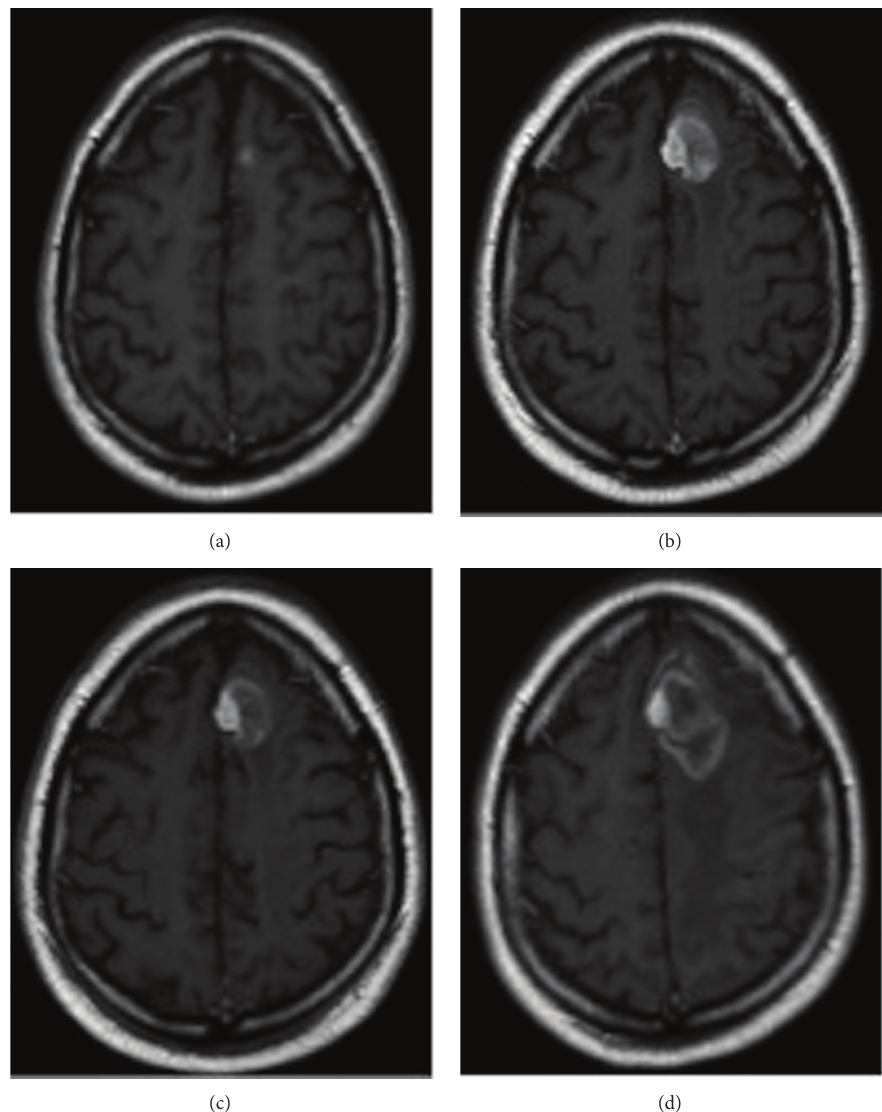
Figure 3: Gadolinium-enhanced T1-weighted MRI images obtained of the MBM of left frontal lobe (a) at diagnosis, (b) prior to SRT, (c) 3 months after SRT, and (d) prior to neurosurgery which revealed RNB